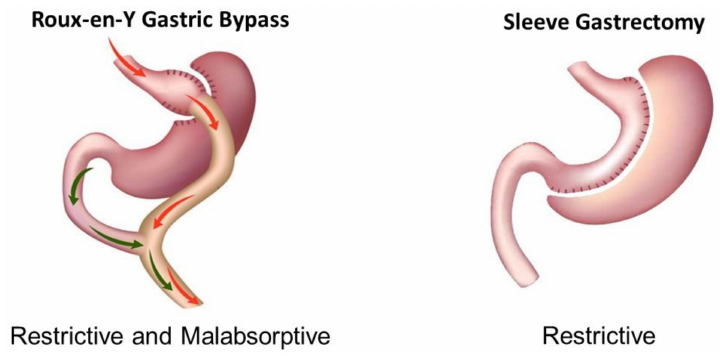
Figure 1. Common metabolic (bariatric) surgical